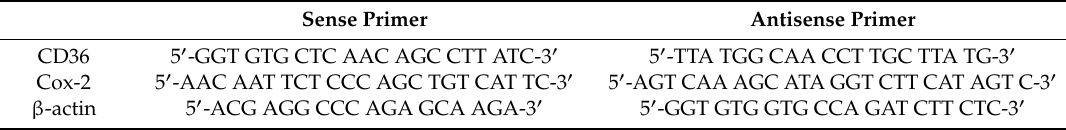
Table 1. Primers for PCR amplification of each studied